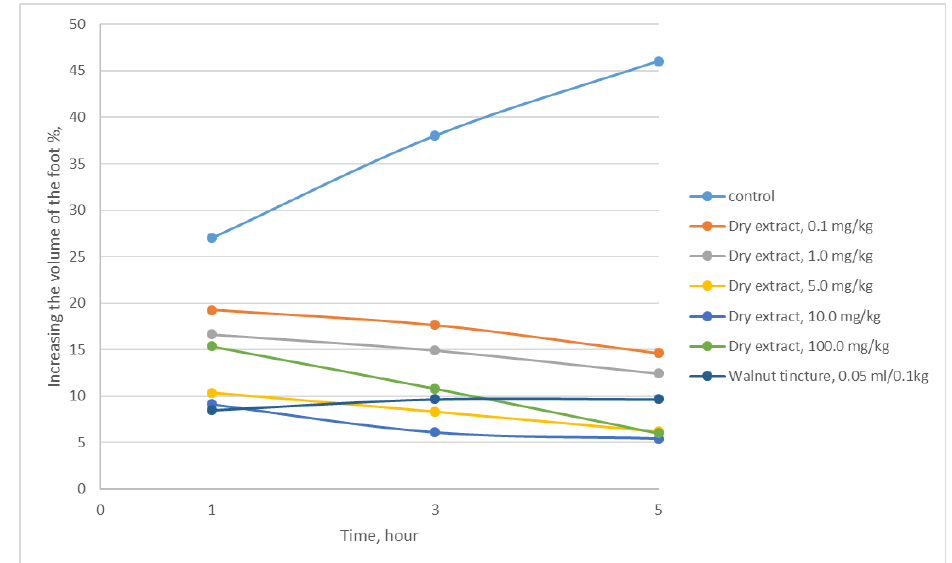
Figure 3. The effect of the herb extract of A. eupatoria on the development of limb swelling in rats. Table 5. Anti-exudative activity of the herb extract of A. eupatoria.